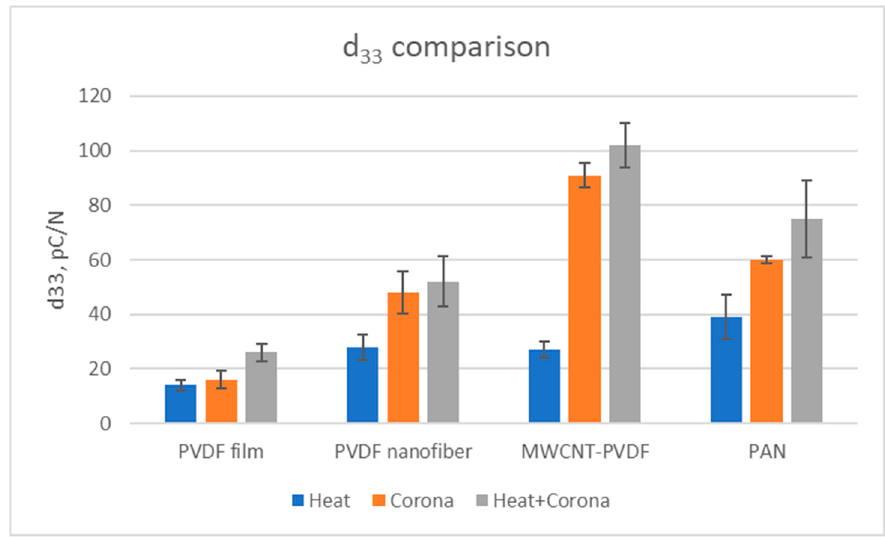
Figure 20. Comparison of d 33 of all nanofiber membranes and films .